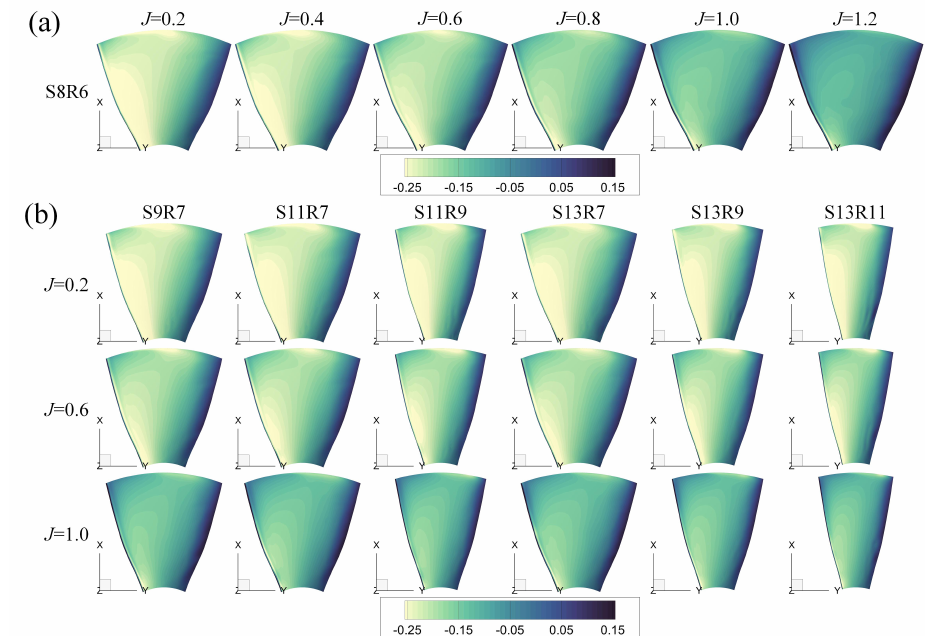
Figure 19. Pressure distribution on the suction side of a rotor blade. ( a ) PJP model S8R6, ( b ) derived PJP models ID 2-7.